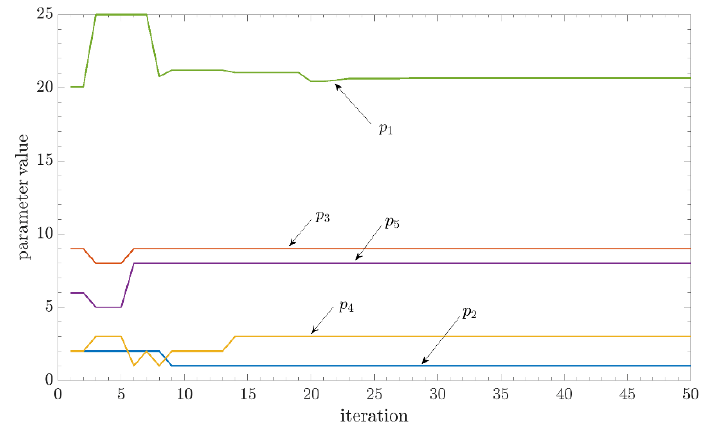
Figure 13. The results of optimization parameters in various iterations for a large substation.